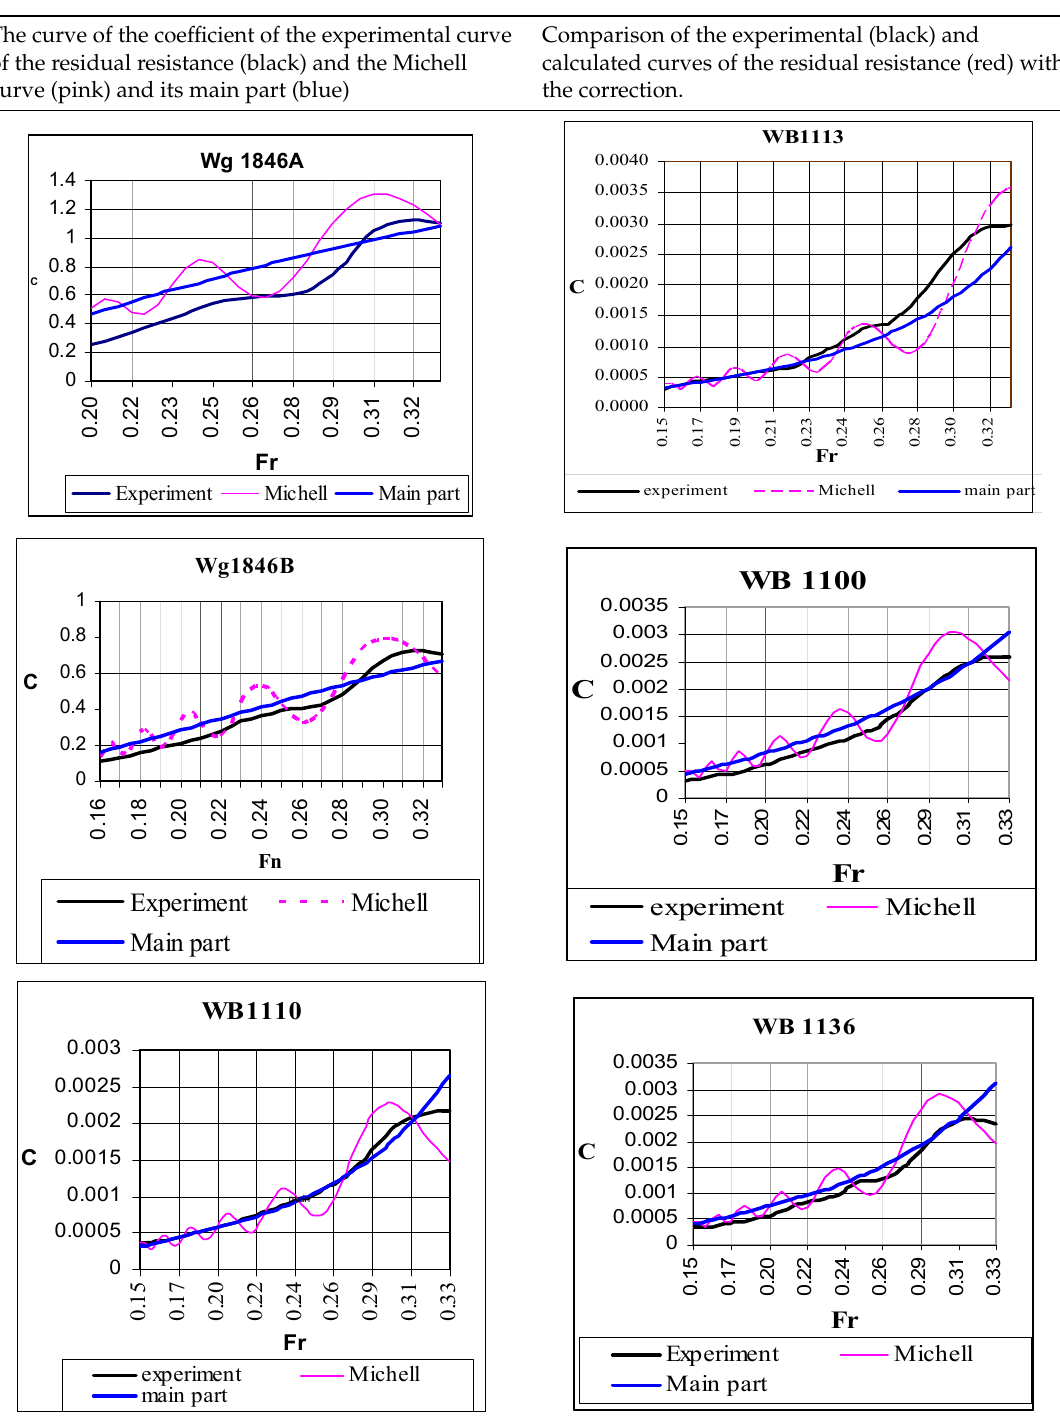
Table 7. Examples of calculations of residual resistance G.Weinblum and W.Wigley models.